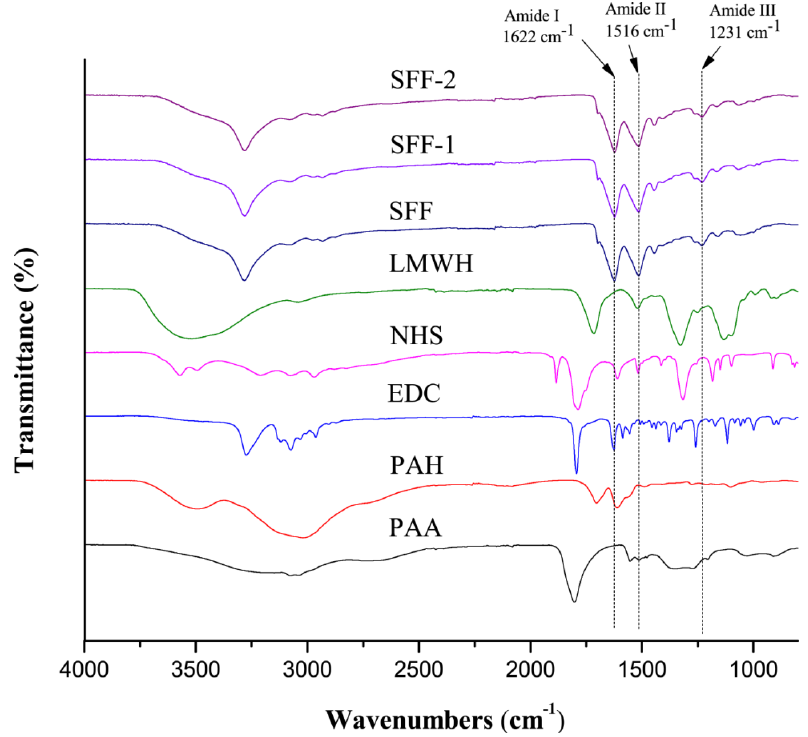
Figure 3. FTIR spectra of poly(acrylic acid) (PAA); poly(allylamine hydrochloride) (PAH); 1-ethyl-3-(dimethylaminopropyl) carbodiimide hydrochloride (EDC); N-hydroxysuccinimide (NHS); low molecular weight heparin (LMWH); SFF, SFF-1 and SFF-2.